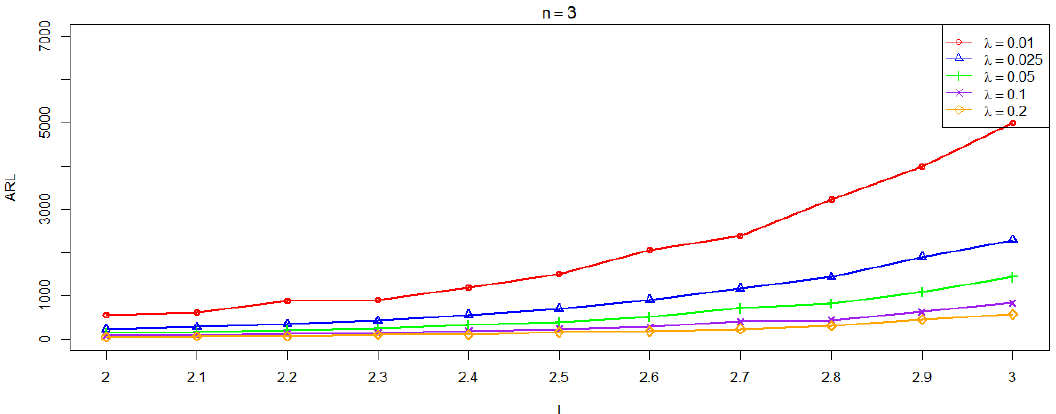
Figure 1. IC average RL (ARL) of the proposed chart for various (𝜆 and 𝐿 1 ) under 𝑚 = 3 and 𝑛 = 3. Using the information given in Table 1, values of 𝐿 1 are reported in Table 2 with different combinations of 𝑚, 𝑛, and 𝜆 at a nominal value of ARL 0 ≅ 370 (cf. Table 2). For practical implementation of the proposed scheme, these values are very useful for the practitioners. For example, a quality practitioner want to spot the small and moderate shifts in the process location; using the proposed scheme, he must take (𝜆, 𝐿 1 ) = (0.05, 2.492) to fix ARL 0 ≅ 370, at 𝑚 = 3 and 𝑛 = 3 (cf. Table 2). Table 2. Values of 𝐿 1 having various combinations of 𝜆, 𝑚, and 𝑛 with IC ARL ≅ 370. m n